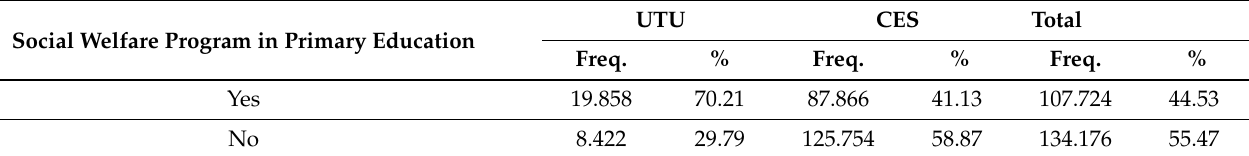
Table 2. Number of students on social welfare programs per